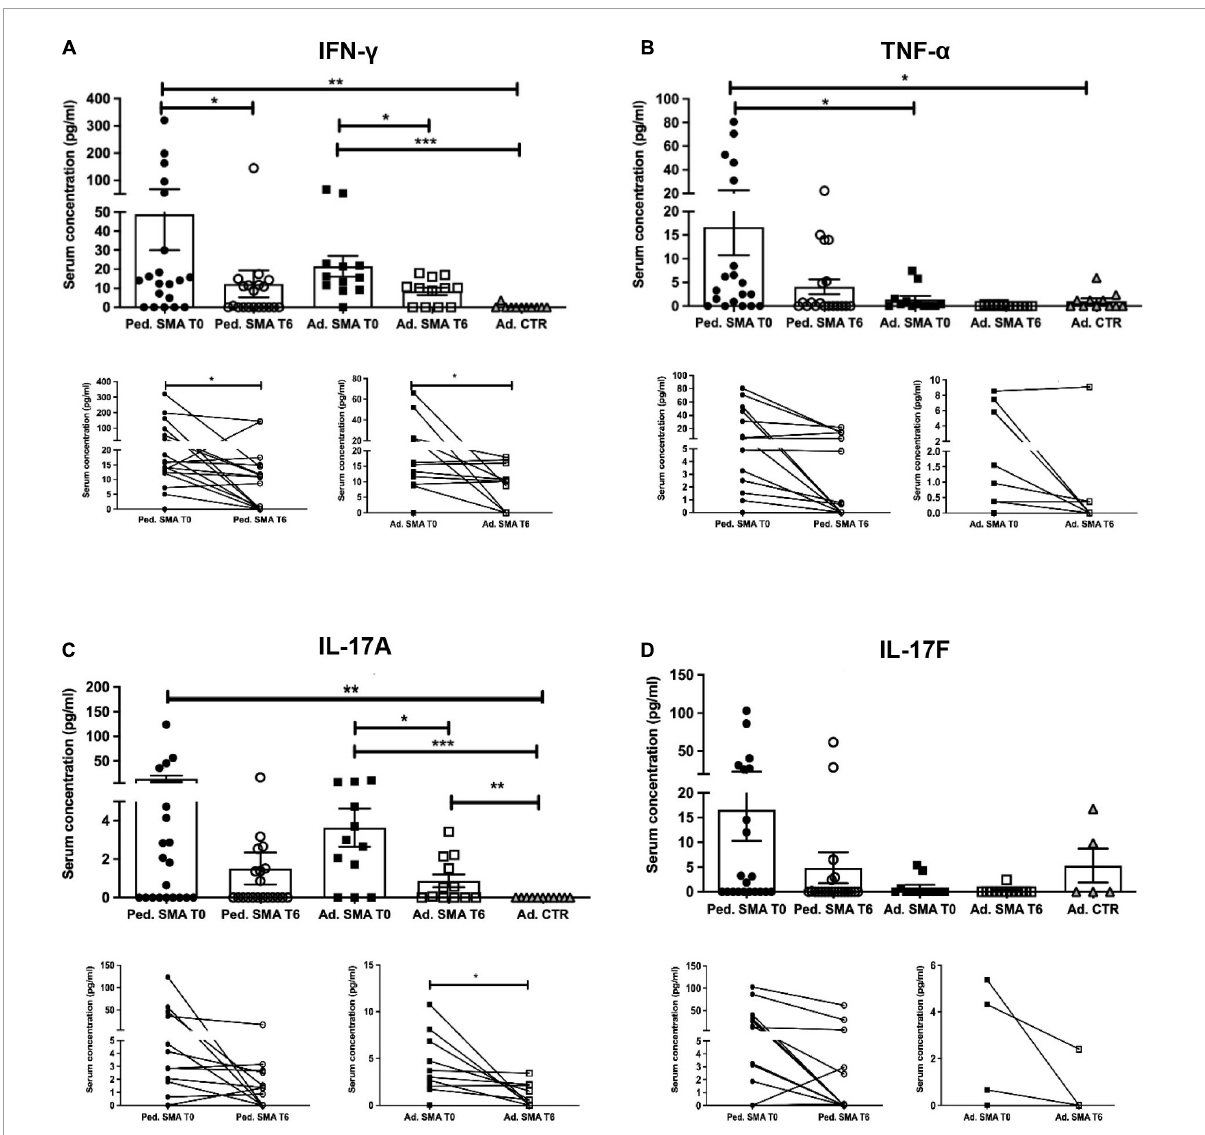
FIGURE2 Levels of cytokines in the serum of pediatric and adult spinal muscular atrophy (SMA) patients. The concentration (pg/ml) of (A) IFN- γ , (B) TNF- α , (C) IL-17A, and (D) IL-17F was measured in the serum of pediatric (Ped.; circle, N = 21) and adult (Ad.; square, N = 12) SMA patients at baseline (T0 black) and after 6 months of nusinersen treatment (T6 white), and in healthy controls (gray triangle) by multiplex immunoassay. Data in the graphs are reported as mean ± SEM for each sample group. The before-after graphs contains the mean cytokine concentration obtained for each patient in the duplicate multiplex immunoassays reactions before and after 6 months of nusinersen treatment (T0 and T6). * p < 0.05, ** p < 0.001, p < 0.0001*** by Mann–Whitney test.